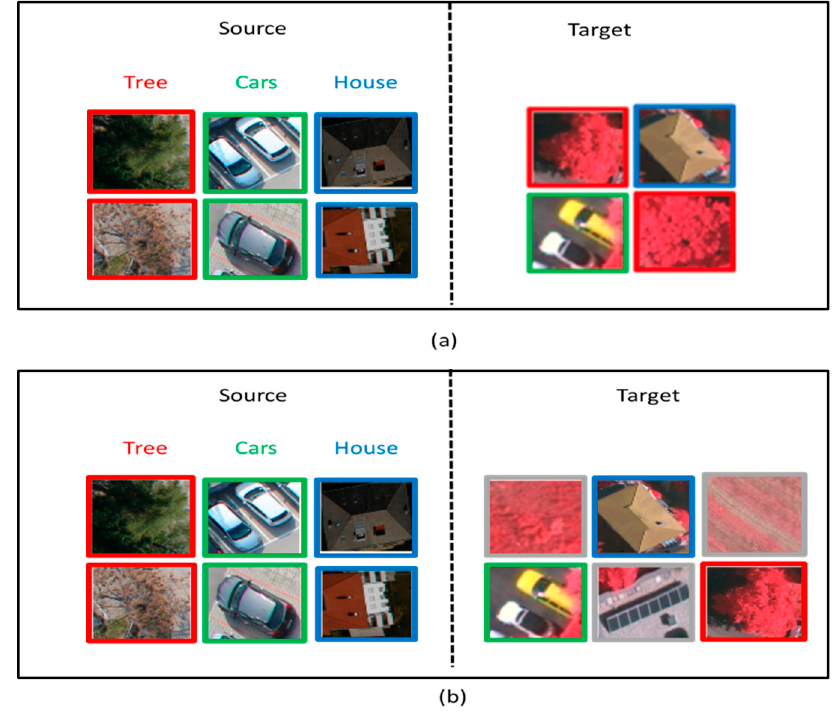
Figure 1. ( a ) Closed set domain adaptation: source and target domains share the same classes. ( b ) Open set domain adaptation: target domain contains unknown classes (in the grey boxes).